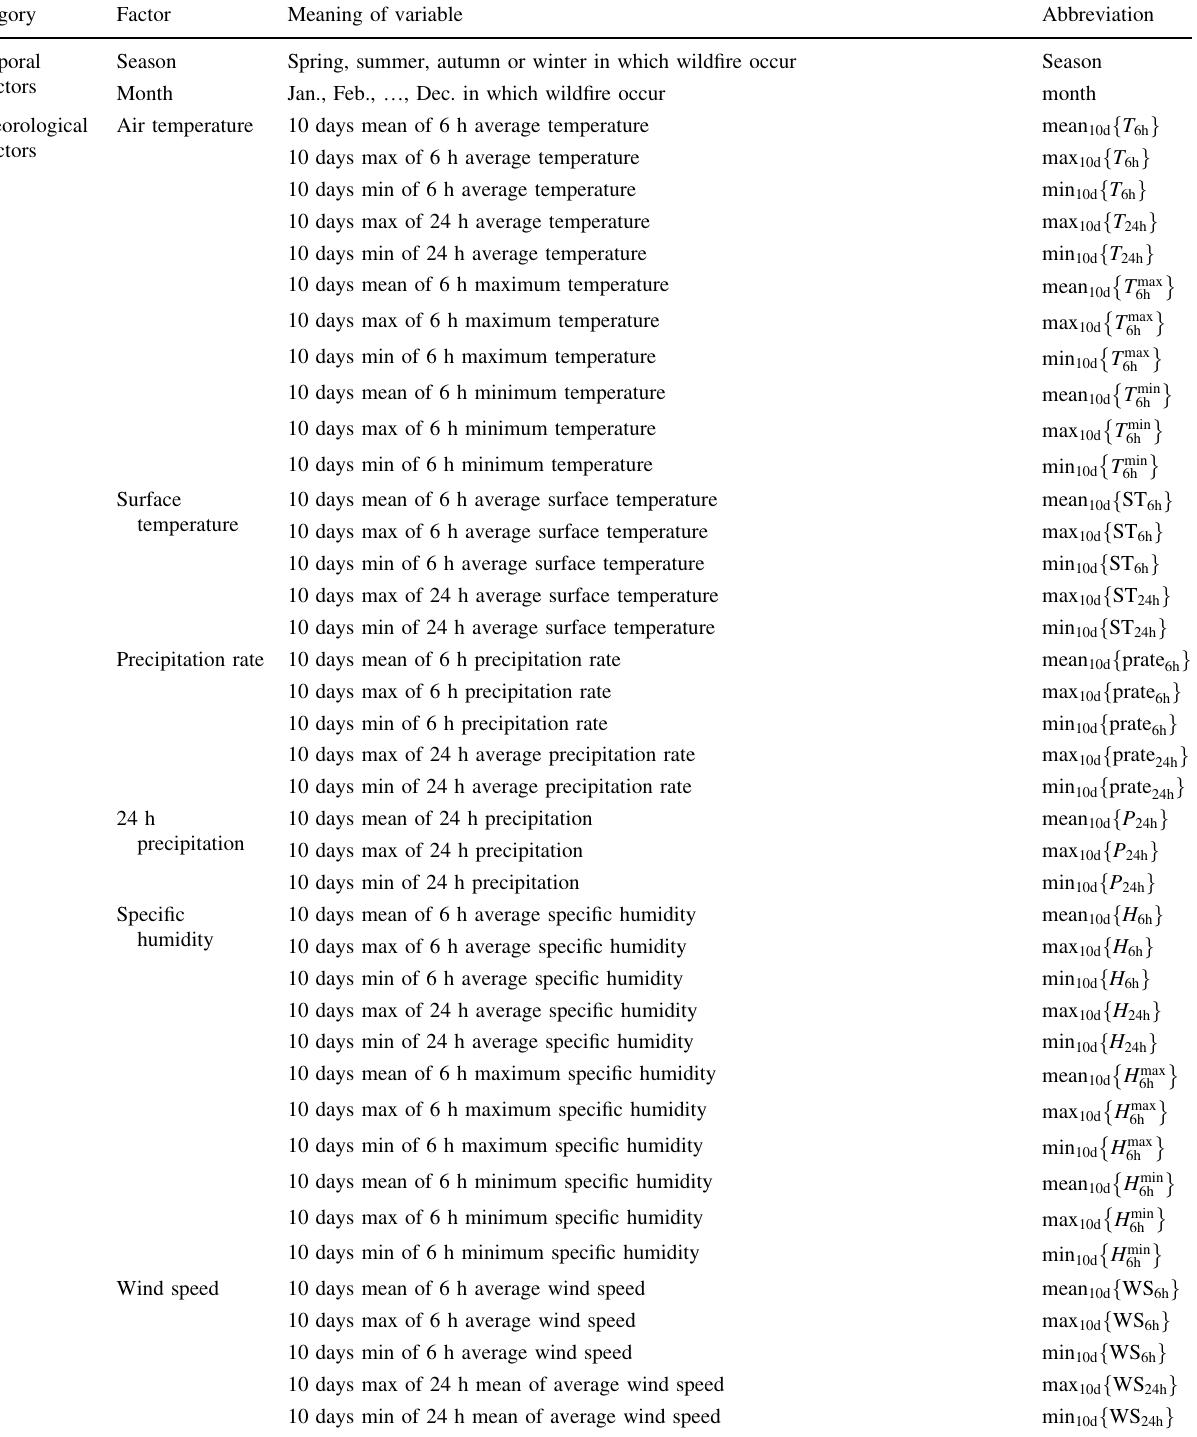
Table 1 List of variables used in the models